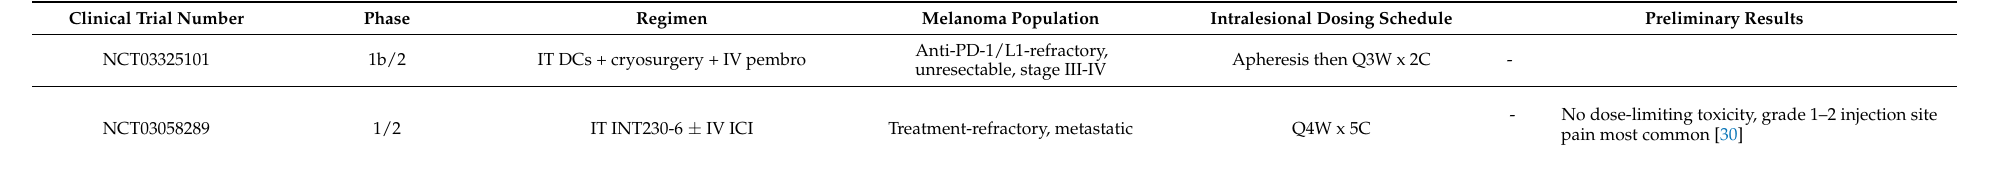
Table 1 abbreviations: IT, intratumoral; IV, intravenous, pembro, pembrolizumab; ICI, immune checkpoint inhibitor; Q, every; W, week; x, times; C, cycle; ORR, overall response rate; IL-2, interleukin-2; XRT, external beam radiation therapy; PD-1, programmed cell death protein 1; PD-L1, programmed death-ligand 1; BCG, bacillus Calmette–Guerin; Tavo-EP,